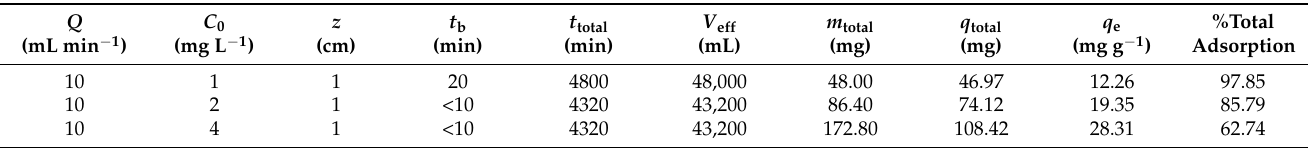
Table 2. Influence of the phosphate initial concentration on experimental breakthrough parameters for phosphate adsorption by monolithic Cry–CSH.